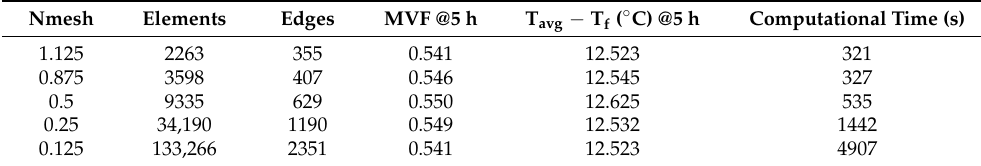
Table 2. The specification of investigated